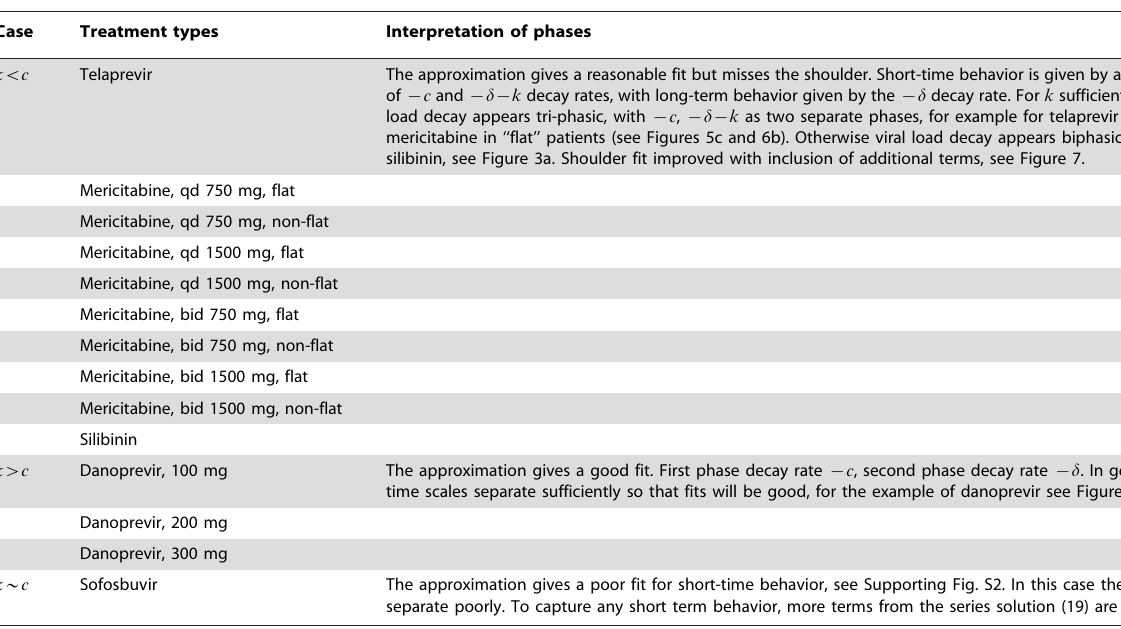
Table 2. Goodness of approximation, Eq. (16), for ranges in the parameter k .